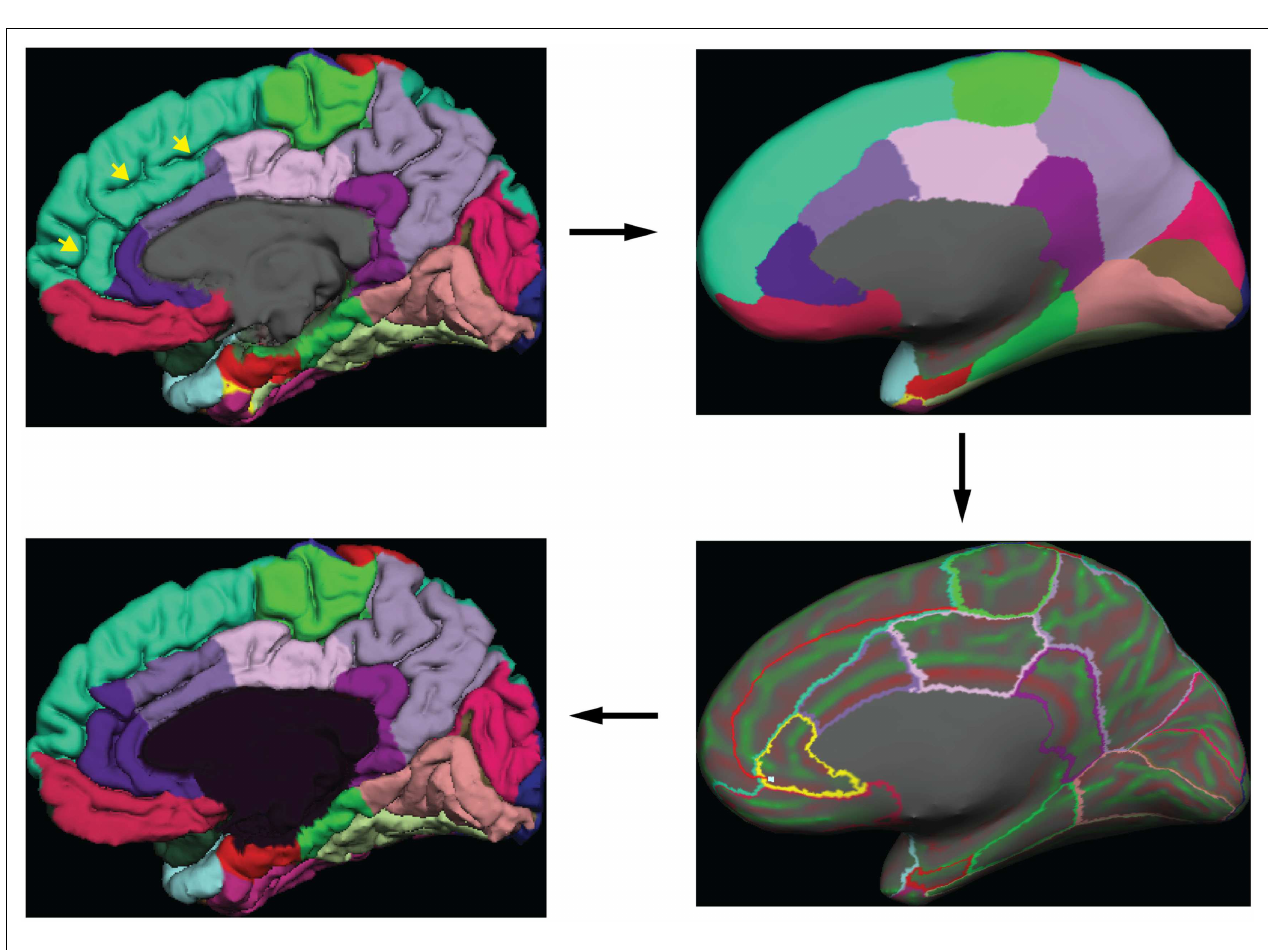
makes the cortical curvature map viewable.The rater then uses the curvature information to draw a line connecting vertices along the fundus of the parallel cingulate sulcus. Additional lines are drawn to subdivide the cingulate gyrus and the new regions are filled and labeled appropriately (bottom left panel).The yellow highlighted outline in the lower right panel indicates the last selected region (rostral anterior cingulate) and the light blue cursor mark within that region indicates the last selected surface